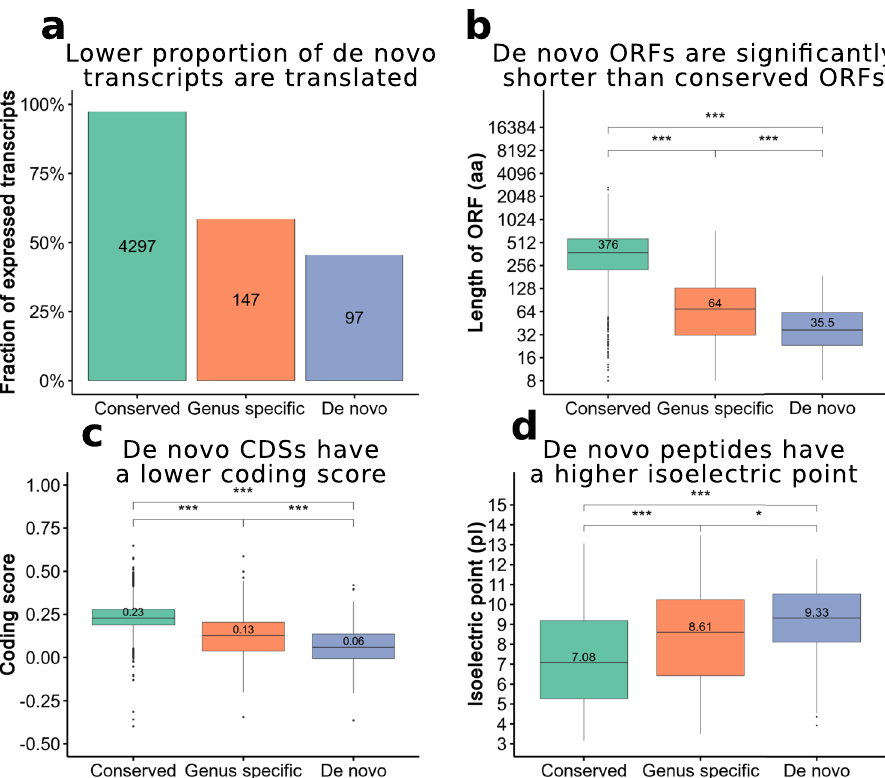
Fig. 4 Features of de novo proteins. a Identi fi cation of transcripts containing putative translated ORFs using ribosome pro fi ling data and annotations. Using ribosome pro fi ling data from yeast grown in rich media and oxidative stress conditions as well as all the annotated CDS information, we identi fi ed 97 de novo, 147 genus-speci fi c and 4297 conserved transcripts with at least one translated open reading frame (ORF). The translated ORFs were detected by RibORF on the basis of high read 3-nucleotide periodicity and uniformity, using a score cut-off of 0.7, in one or both conditions. For sections b, c, and d we selected the longest translated ORF per transcript (Conserved n = 4297; Genus-speci fi c n = 147; De novo n = 97). b Length of translated ORFs in different phylogenetic conservation classes. The length of the longest translated ORF per transcript showed a positive relationship with the conservation level. The median length is indicated in the plot. Length is in amino acids (aa). The values of each boxplot are as follows: ‘ Conserved ’ min 5.81, 25% percentile 7.82, median 8.55, 75% percentile 9.16, max 11.13; ‘ Genus speci fi c ’ min 3, 25% percentile 4.98, median 6.11, 75% percentile 7.02, max 9.5; ‘ De novo ’ min 3, 25% percentile 4.52, median 5.19, 75% percentile 5.94, max 7.55. c Coding score of translated ORFs in different phylogenetic conservation classes. Coding score was calculated using a previously developed hexamer-based metric called CIPHER, which measures codon usage bias of putatively coding sequences with respect to non-coding sequences. Coding score shows a signi fi cantly positive relationship with the transcript conservation level. The values of each boxplot are as follows: ‘ Conserved ’ min 0.05, 25% percentile 0.19, median 0.23, 75% percentile 0.28, max 0.41; ‘ Genus speci fi c ’ min − 0.2, 25% percentile 0.04, median 0.13, 75% percentile 0.2, max 0.45; ‘ De novo ’ min − 0.21, 25% percentile − 0.01, median 0.06, 75% percentile 0.14, max 0.32. d Isoelectric point (IP) of translated ORFs in different phylogenetic conservation classes. IP was predicted with the R package ‘ Peptides ’ , using the EMBOSS pKscale. Data are for the longest translated ORF per transcript. The values of each boxplot are as follows: ‘ Conserved ’ min 3.14, 25% percentile 5.26, median 7.08, 75% percentile 9.19, max 13.06; ‘ Genus speci fi c ’ min 3.49, 25% percentile 6.43, median 8.61, 75% percentile 10.24, max 13.46; ‘ De novo ’ min 4.54, 25% percentile 8.12, median 9.33, 75% percentile 10.55, max 12.3. Signi fi cance between the distributions of the values for different variables was calculated with pairwise two-sided Wilcoxon tests; p -values are as follows: 4b) Gs-C < 2e-16; Dn-C < 2e-16; Dn-Gs <6.3e-05, 4c) Gs-C < 2e-16; Dn-C < 2e-16; Dn-Gs <5.8e-05, 4d) Gs-C 3.9e-06; Dn-C 8.5e-14; Dn-Gs 0.01; where Gs is Genus-speci fi c, Dn is De novo and C is Conserved. Source data are provided as a Source Data fi